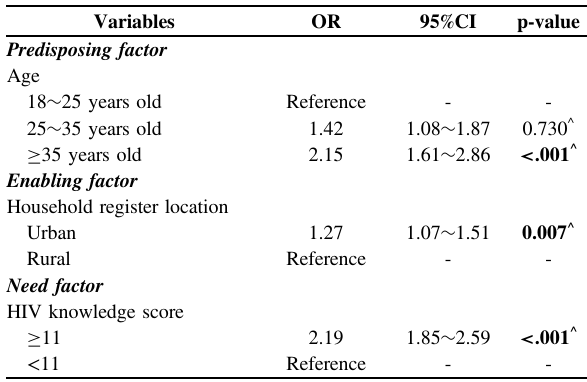
Table 4 Multivariate logistic regression analysis of HIV counselling among MSM population based on Andersen ’ s Behavioral